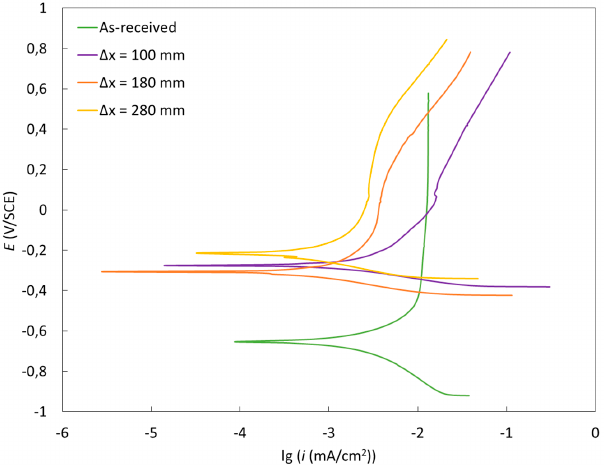
Figure 6. Potentiodynamic curves for as-received and laser-textured Ti-6Al-4V surfaces in Hank ׳ s solution. Table 4. Electrochemical parameters determined from the potentiodynamic curves.